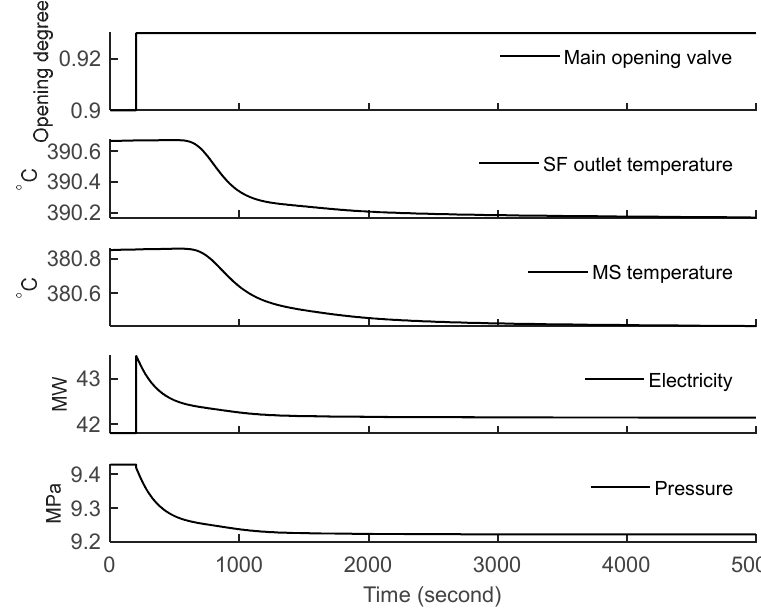
Figure 4. System response to step change of main valve opening.